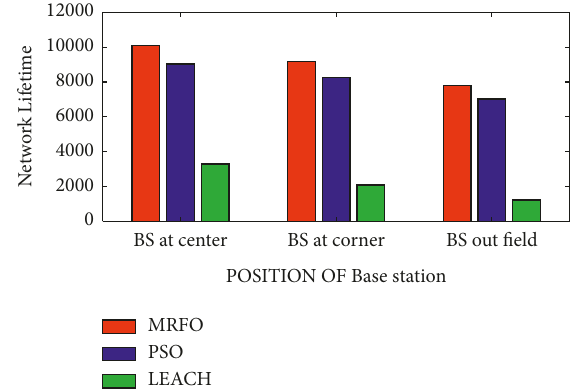
Figure 20: Number of rounds (lifetime) for 500-node network with 50